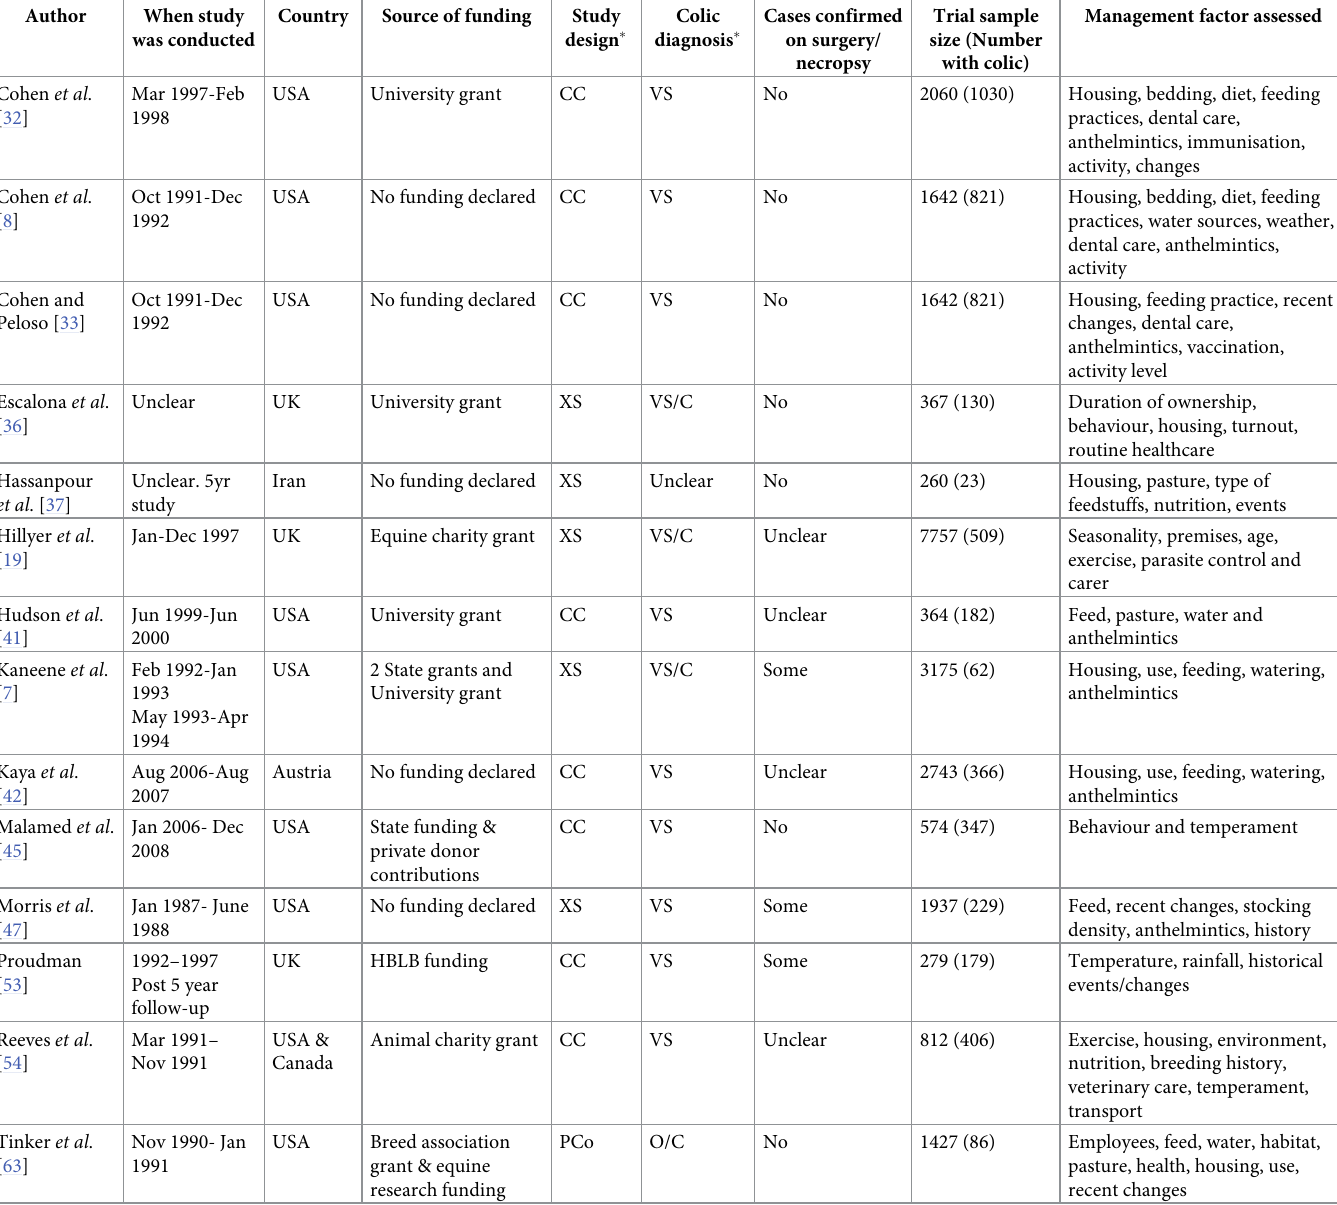
Table 5. Data extraction- Study characteristics for publications included in a systematic review of management risk factors for colic in the